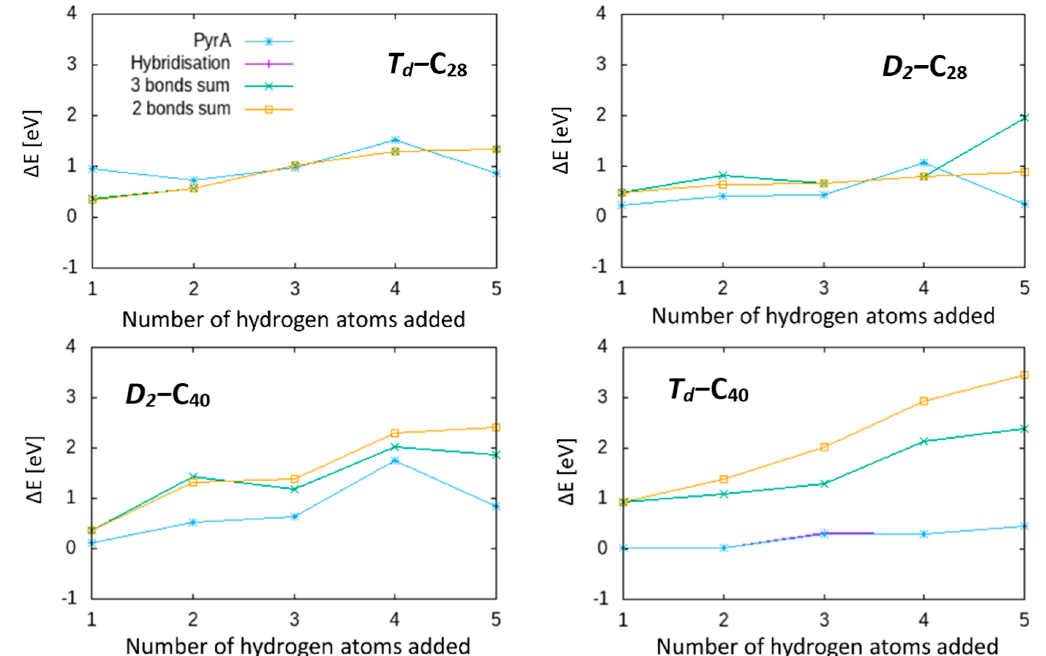
Figure 5. Plots of the difference in calculated total energy via DFT-LDA between hydrogenated fullerene structures, with hydrogen site selection based on geometric parameters (pyrA and hybridisation, and sum of two- or three-bond lengths), compared to the lowest-energy hydrogenated isomer found through sequential addition from Section 3.2 Structures are C 28 (1- Td and 2- D 2 ) and C 40 (38- D 2 and 40- Td ).